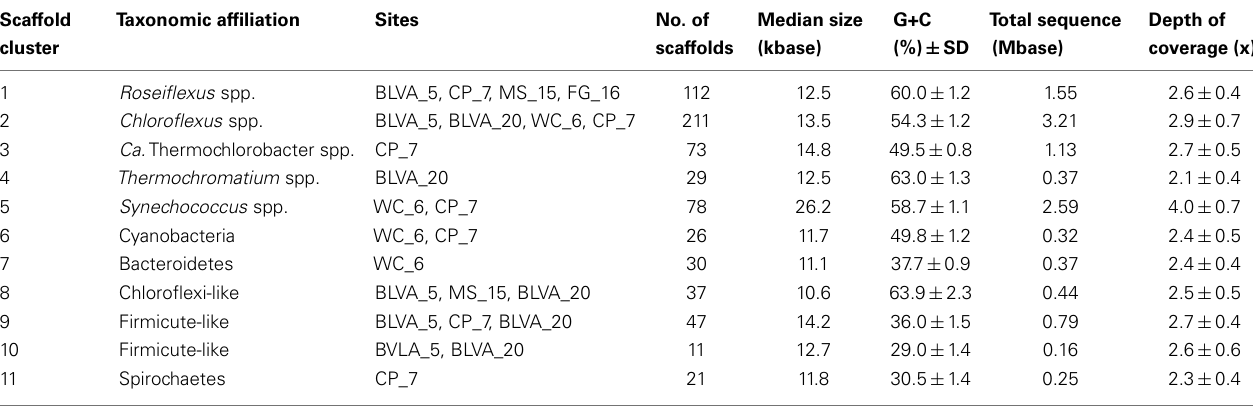
Table 2 | Properties of scaffold clusters obtained from metagenome assemblies as demarcated with oligonucleotide composition and confirmed using phylogenetic